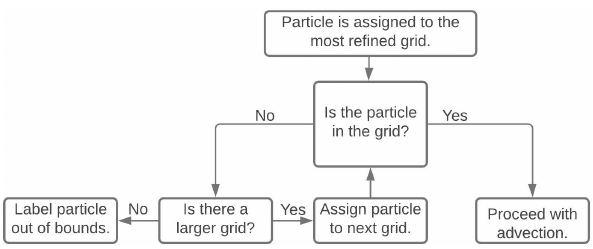
Figure 2. Flow diagram of the grid assignment process. At each time step particles are assigned to the most refined grid first. If the particle is determined to be within that grid domain, advection con- tinues. If the particle is outside the domain, the next refined grid is checked. If the particle is not found to be within the domain of any grid, advection for that particle